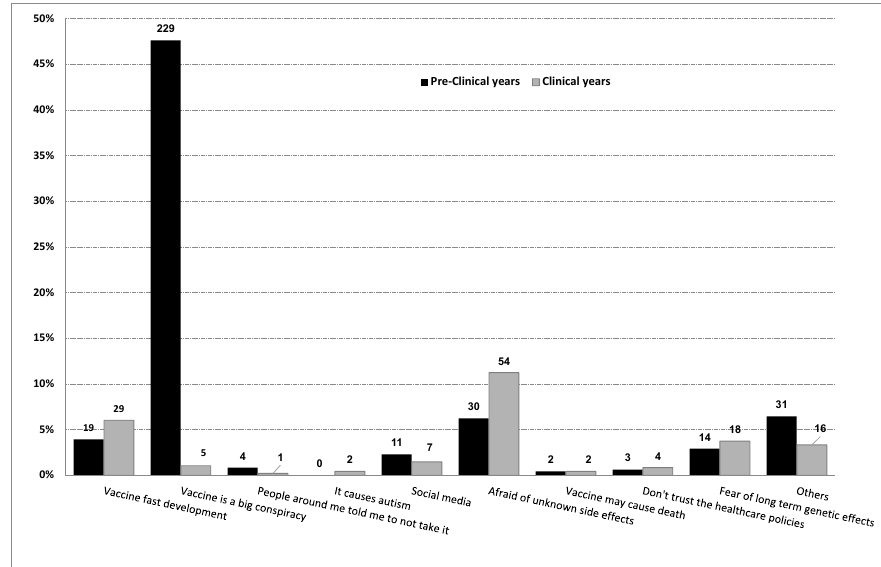
Figure 1. Reasons explaining negative attitudes toward COVID-19 vaccination for participants who were hesitant to be